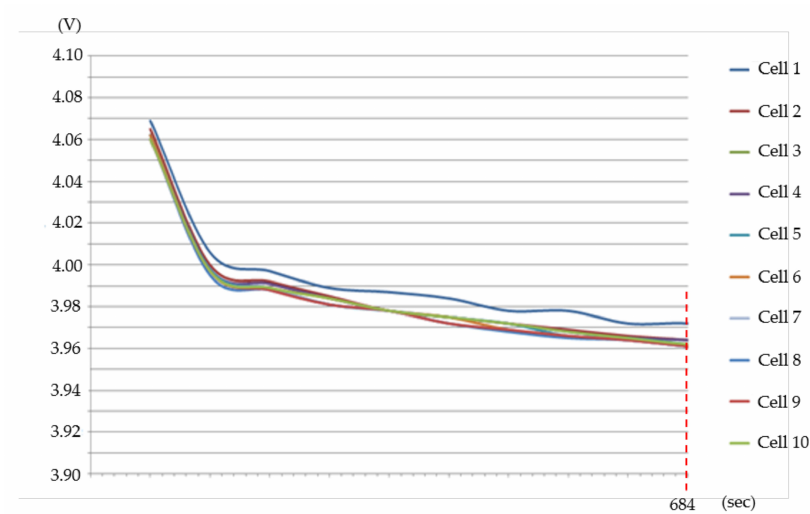
Figure 11. Partial enlargement of the discharge curve measured by